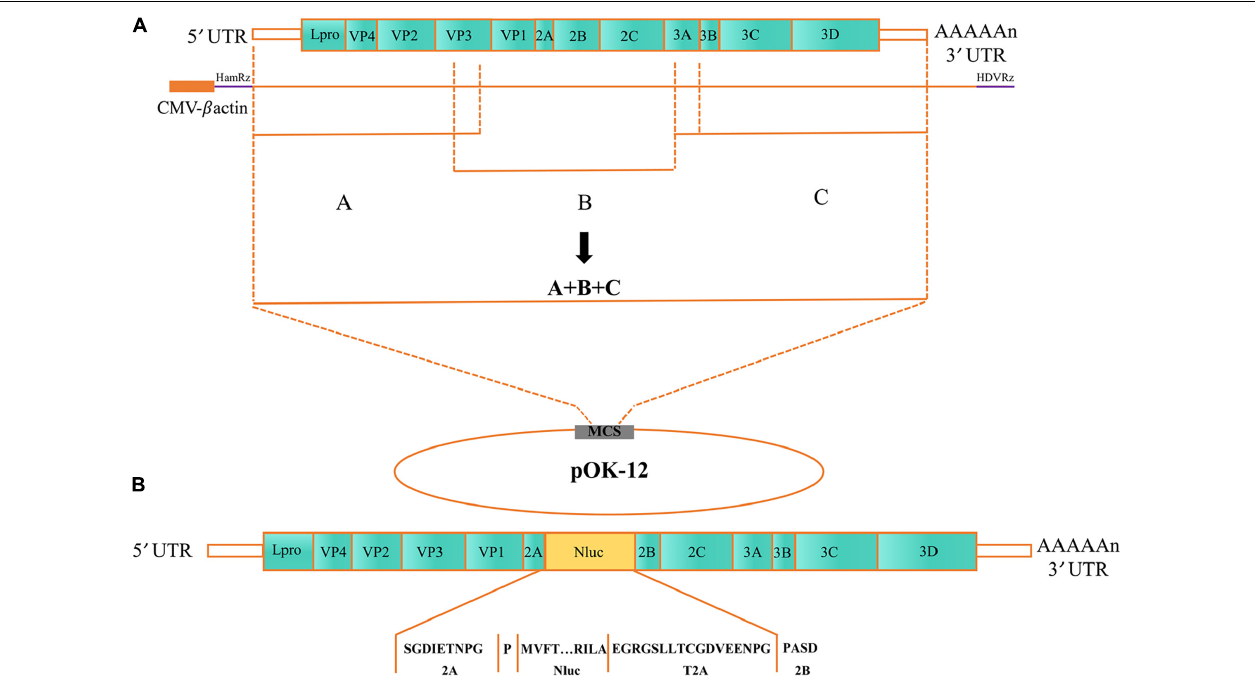
FIGURE 1 | The schematic diagram for the construction of Senecavirus A (SVA)-HeB. (A) Schematic diagram of the full-length SVA genome and construction of the full-length cDNA clone. The open reading frames (ORFs) are flanked by 5 (cid:48) and 3 (cid:48) UTR followed by the poly(A) tail at the 3 (cid:48) end. Three separate genomic fragments (A–C) were synthesized and assemble into the pOK12 vector using the NEBuilder HiFi DNA Assembly Cloning Kit. The full-length viral genome is under the control of a CMV enhancer and β -actin promoter. (B) A scheme of the reporter virus genome with a Nluc-T2A fusion gene inserted between SVA 2A and 2B. CMV, cytomegalovirus enhancer; β -actin, beta-chicken actin promoter; HamRbz, hammerhead ribozyme; HDVRz, hepatitis delta virus ribozyme.